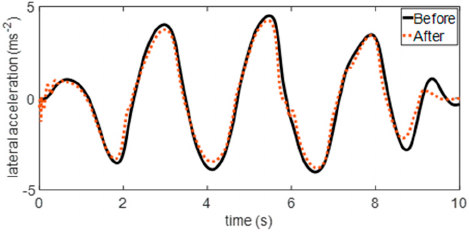
Figure 10. Lateral acceleration response.